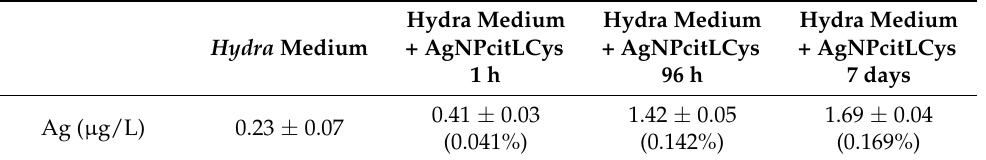
Table 2. Reported Ag values ( µ g/L) as measured by ICP-MS in Hydra medium and Hydra medium with 1000 µ g/L AgNPcitLcys after 1 h, 96 h, and 7 days after filtration (3 kDa). Data are shown as mean ± standard deviation and dissolution percentage of nominal